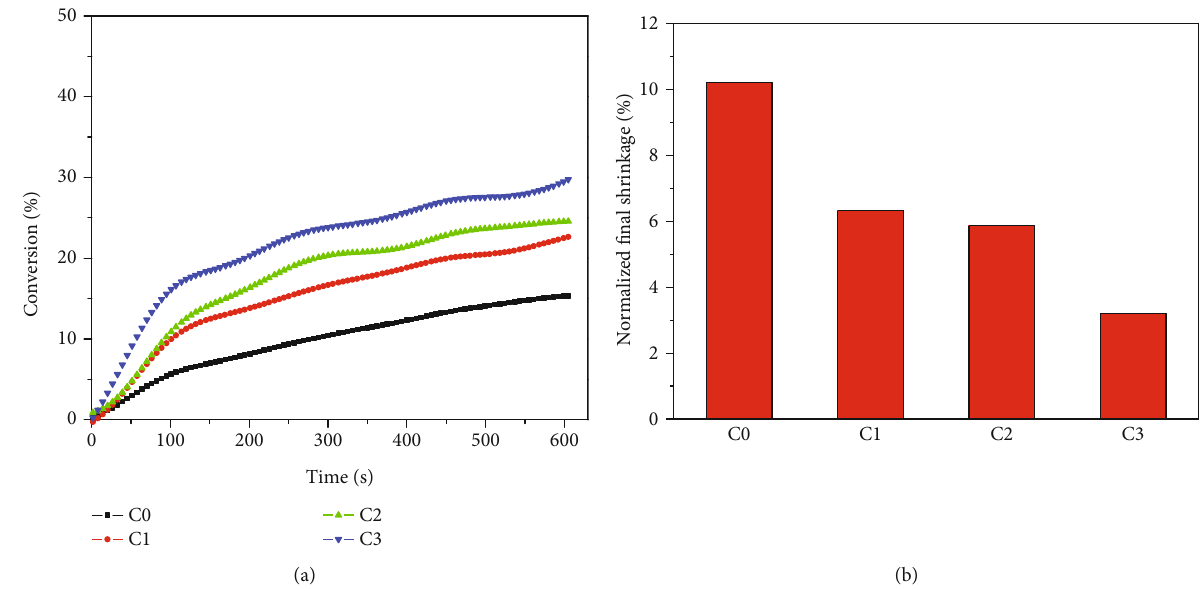
Figure 1: Epoxy conversion (a) and normalized fi nal shrinkage (b) of di ff erent